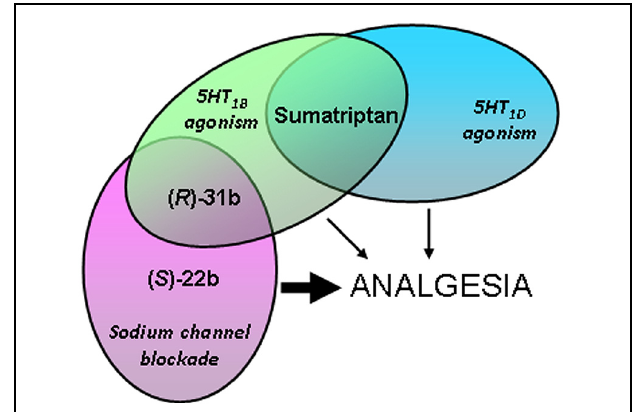
FIGURE 6 | Cartoon depicting hypothesis regarding pharmacological actions of exploratory compounds displaying analgesic activity in vivo , based on the results obtained in the present and previous studies (Carocci et al., 2010). The thickness of the arrows indicates the intensity of the analgesic activity exerted by the